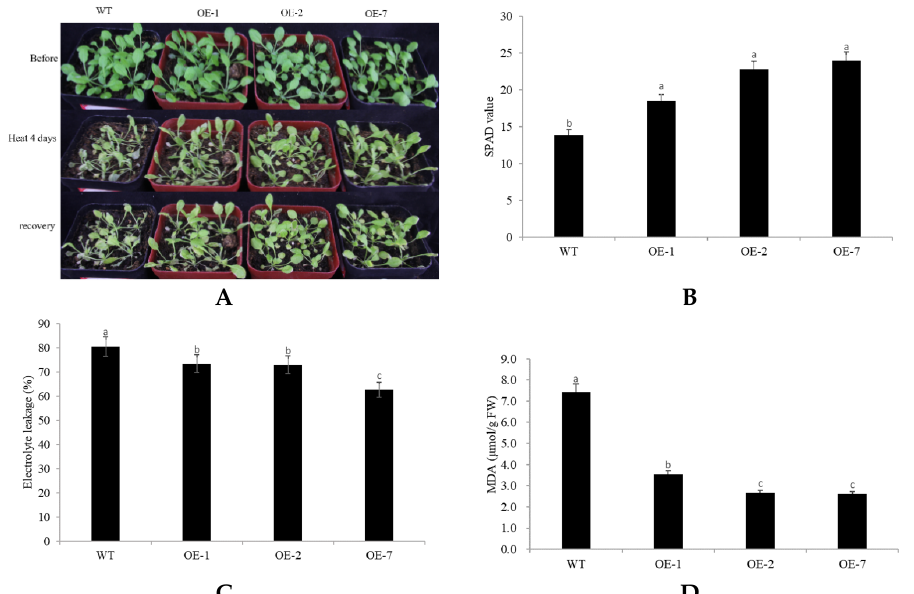
Figure 5. Ectopic expression of CpNAC68 confers enhanced tolerance to heat stress in transgenic Arabidopsis. ( A ) Performance of overexpression in OE lines and WT plants after heat stress for 4 days, followed by recovery at normal conditions for 3 days. Images were taken at the indicated time points. ( B ) SPAD values of OE lines and WT plants under heat treatment. ( C ) Electrolyte leakage of plants under heat treatment. ( D ) MDA content of plants under heat treatment. Values are the averages of three independent repeated trials. Data represent the mean ± (SE). Bars correspond to the standard error. The significance test was performed by Duncan’s multiple range test, which is indicated by different letters.